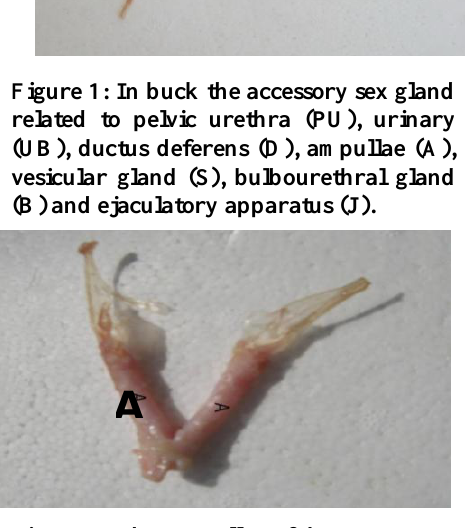
Figure 3: The Ampullae of ductus deferens (A) in buck.